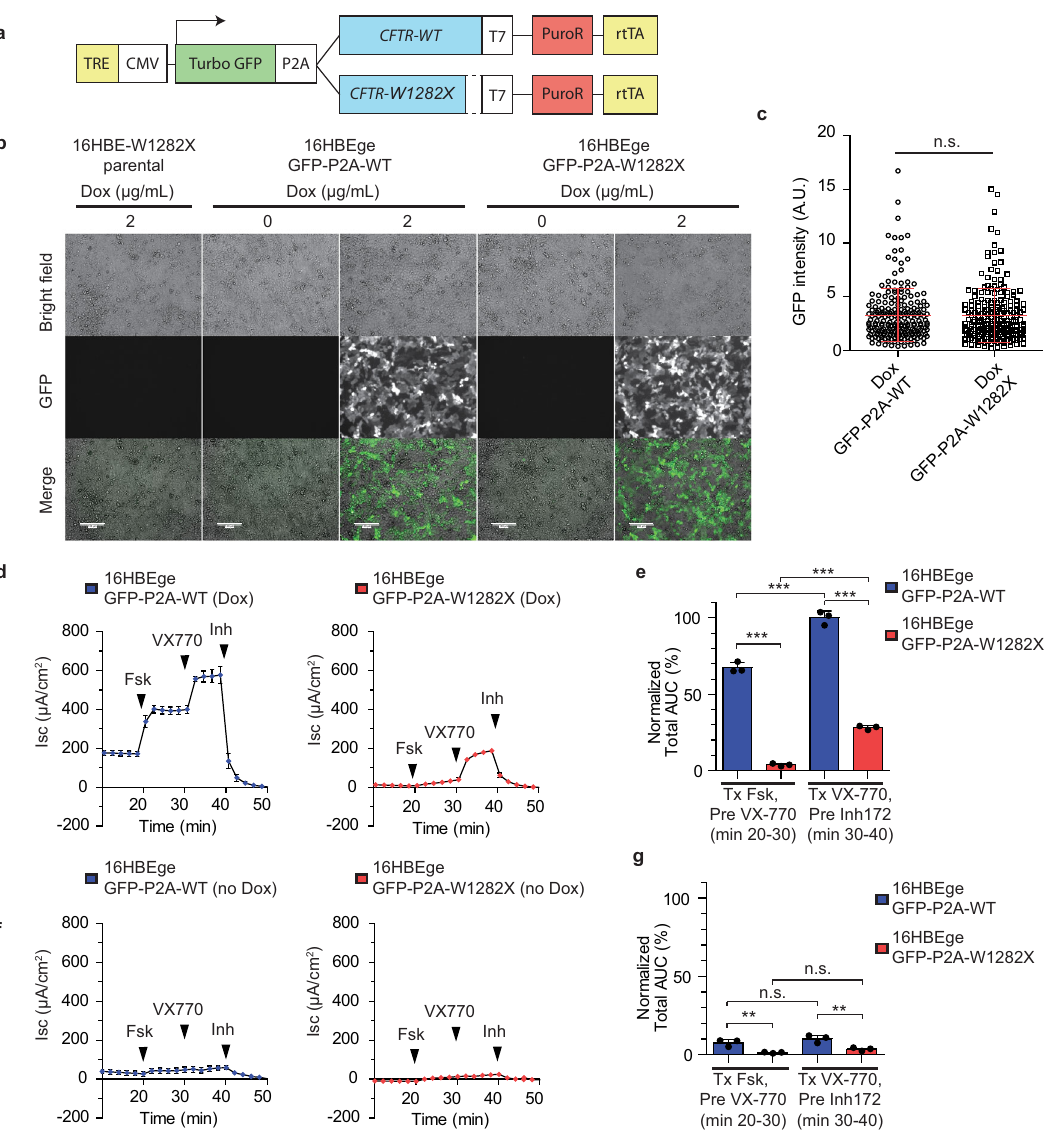
Fig. 4 Intrinsic activity of CFTR-W1282X protein. a Schematic of recombinant CFTR expression system. b Fluorescence microscopy images of 16HBE- W1282X, 16HBEge-GFP-P2A-WT, and 16HBEge-GFP-P2A-W1282X cells treated with doxycycline for 48 h. The white bars are 130- μ m rulers. c TurboGFP signal intensity of 16HBEge-GFP-P2A-WT/W1282X cells treated with doxycycline (2 μ g/mL) in ( b ) measured by fl uorescence microscopy. d Average traces ( n = 3) from Ussing-chamber assays of 16HBEge-GFP-P2A-WT/W1282X cells treated with doxycycline (2 μ g/mL) and Trikafta. e The normalized total area under the curves of ( d ) between minutes 20 – 30 and 30 – 40. f . Average traces ( n = 3) from Ussing-chamber assays of 16HBEge-GFP-P2A-WT/ W1282X cells treated with Trikafta (VX-770/VX-661/VX-445) but no doxycycline. g The normalized total area under the curves of (f) between minutes 20 – 30 and 30 – 40. Data are represented as mean values ± SD. All data points represent independent biological replicates. c ( n = 210 and n = 208 independent cells for 16HBEge-GFP-P2A-WT and 16HBEge-GFP-P2A-W1282X cells, respectively. n.s. P > 0.05, two-tailed Student ’ s t -test). d – g ( n = 3 n.s. P > 0.05, * P < 0.05, ** P < 0.01, *** P < 0.001, one-way ANOVA with Tukey ’ s post-test). Black arrowheads in ( d ) and ( f ) show when Fsk, VX-770, or CFTR inhibitor 172 was added; VX-661/445 treatment was started 24 h prior to the assay. TRE tetracycline-response-element, CMV CMV promoter, P2A self- cleaving 2A peptide, PuroR puromycin-resistance gene, rtTA reverse tetracycline transactivator, Dox doxycycline, Fsk 10 μ M forskolin, AUC area under the curve, VX-770 10 μ M VX-770, Inh 20 μ M CFTR inhibitor 172. Source data are provided as a Source Data File. WT and 16HBEge-GFP-P2A-W1282X cells (Fig. 4a). GFP levels veri fi ed in the cells treated with or without doxycycline (Sup- served to control for expression from the integrated plasmid, as plementary Fig. 12). The reduced level of CFTR-W1282X com- the TurboGFP and CFTR proteins are translated initially as a pared to CFTR-WT is attributable to the lack of C-terminal single polypeptide 49 . Fluorescence microscopy con fi rmed the residues ( 1478 TRL 1480 ) important for post-translational proces- induction of the recombinant gene expression by dox (Fig. 4b). sing and stability of CFTR protein 50,51 . Dox and Trikafta (VX-445, VX-661, and VX-770) treatment GFP signals from 16HBEge-GFP-P2A-WT/W1282X cells treated of 16HBEge-GFP-P2A-WT/W1282X cells led to a signi fi cant with 2 μ g/mL doxycycline were similar, indicating similar levels of increase in CFTR activity, compared to Trikafta-only treatment, induction of the recombinant CFTR proteins (Fig. 4c). The as quanti fi ed by the relative total area under the curve (AUC) expression of recombinant CFTR-WT and CFTR-W1282X was NATURE COMMUNICATIONS| (2022) 13:2978